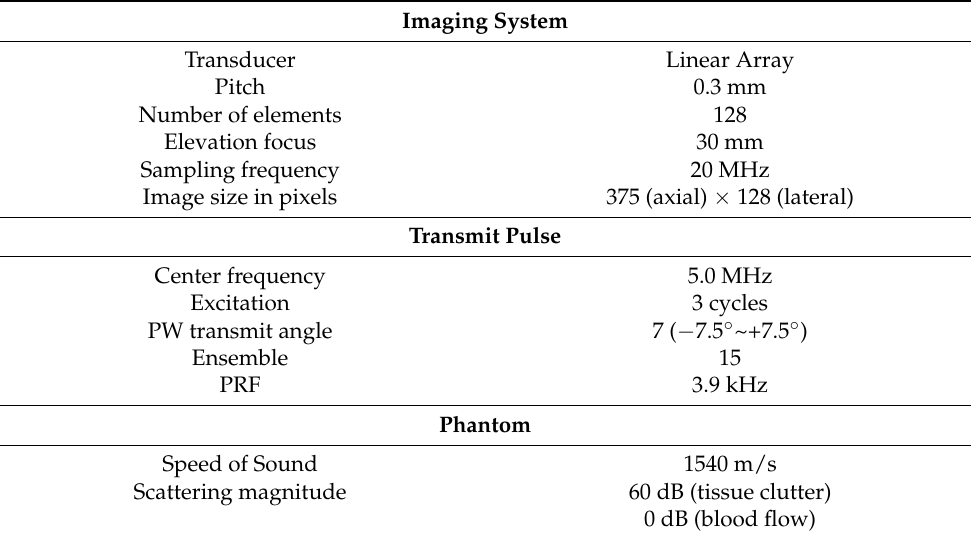
Figure 2. Schematic diagram of the simulated flow channel in the speckle phantom. Note that the intersection of the image plane of the array transducer and the cylindrical vessel will be an ellipse. Table 1. The imaging parameter of Field II simulations.